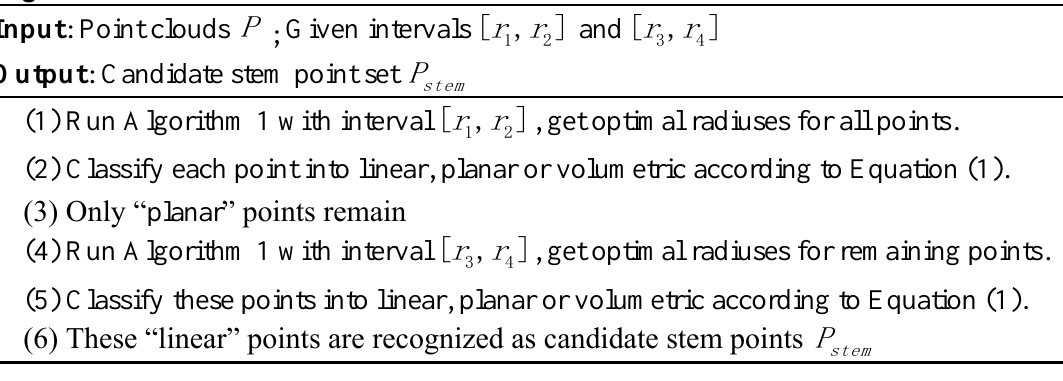
Algorithm 2. Two-scale